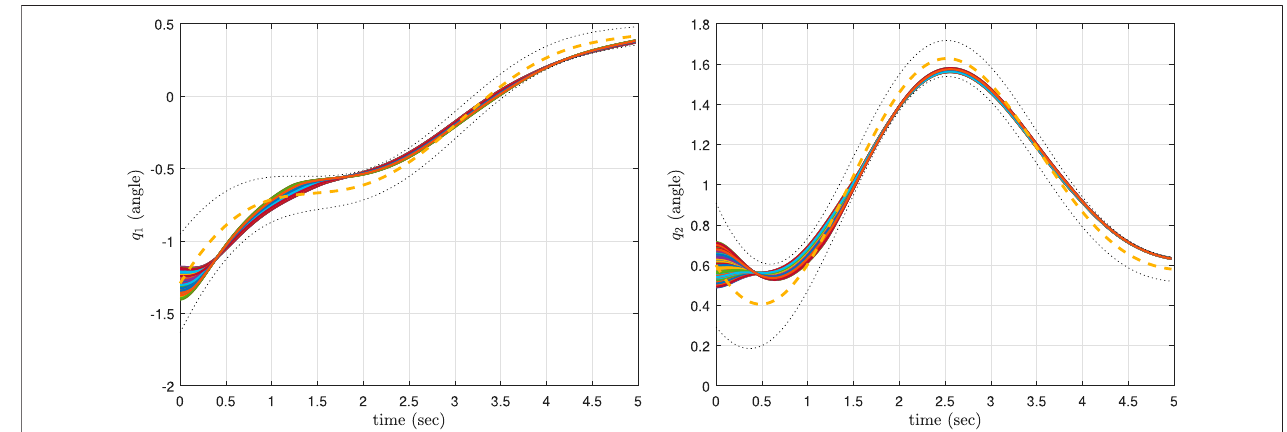
FIGURE 7 | The results of the CLF/CBF-based ProMP controller with more priority given to the CBF than the CLF for the fi rst joint (left) and second joint (right).